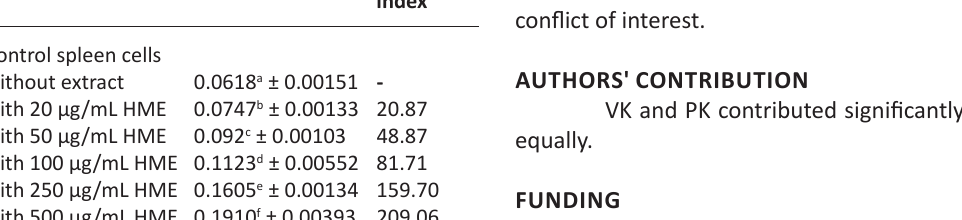
Table 3. In vitro effect of HME of N. cadamba bark on Con-A stimulated Wistar albino rat splenocytes proliferation/inhibition Spleen cell Mean % culture Absorbance stimulation index Control spleen cells without extract 0.0618 a ± 0.00151 - with 20 µg/mL HME 0.0747 b ± 0.00133 20.87 with 50 µg/mL HME 0.092 c ± 0.00103 48.87 with 100 µg/mL HME 0.1123 d ± 0.00552 81.71 with 250 µg/mL HME 0.1605 e ± 0.00134 159.70 with 500 µg/mL HME 0.1910 f ± 0.00393 209.06 The values represent the mean ± SEM of six rats. Results are significant at p<.01 as per one-way ANOVA followed by